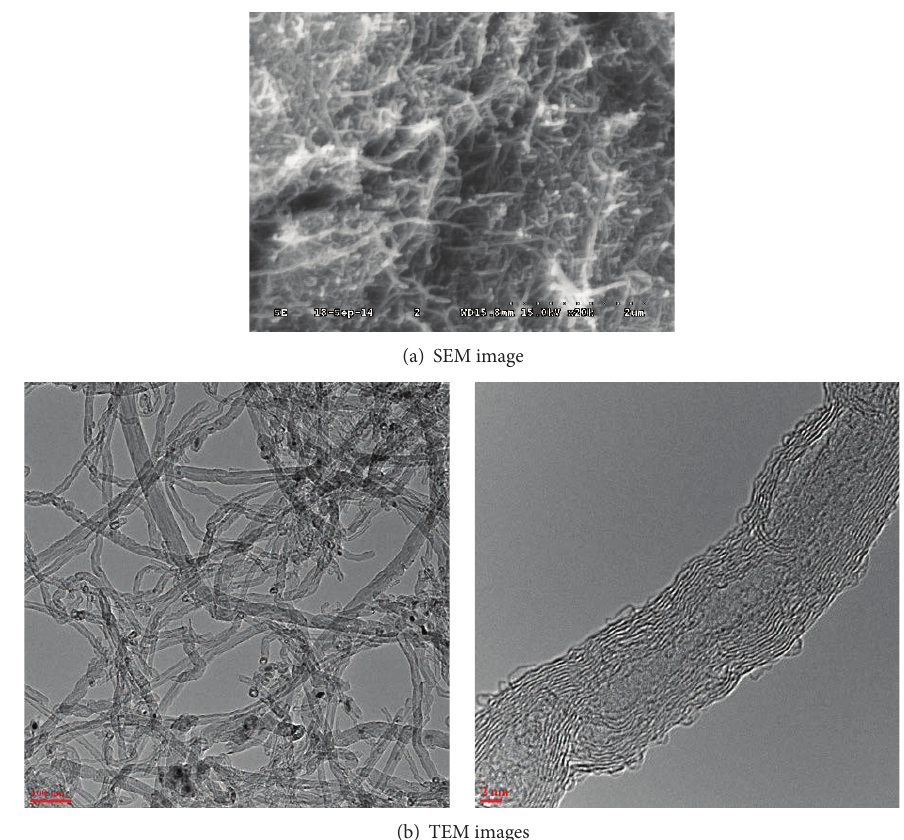
Figure 3: (a) SEM and (b) TEM images of acid-treated MWCNTs.